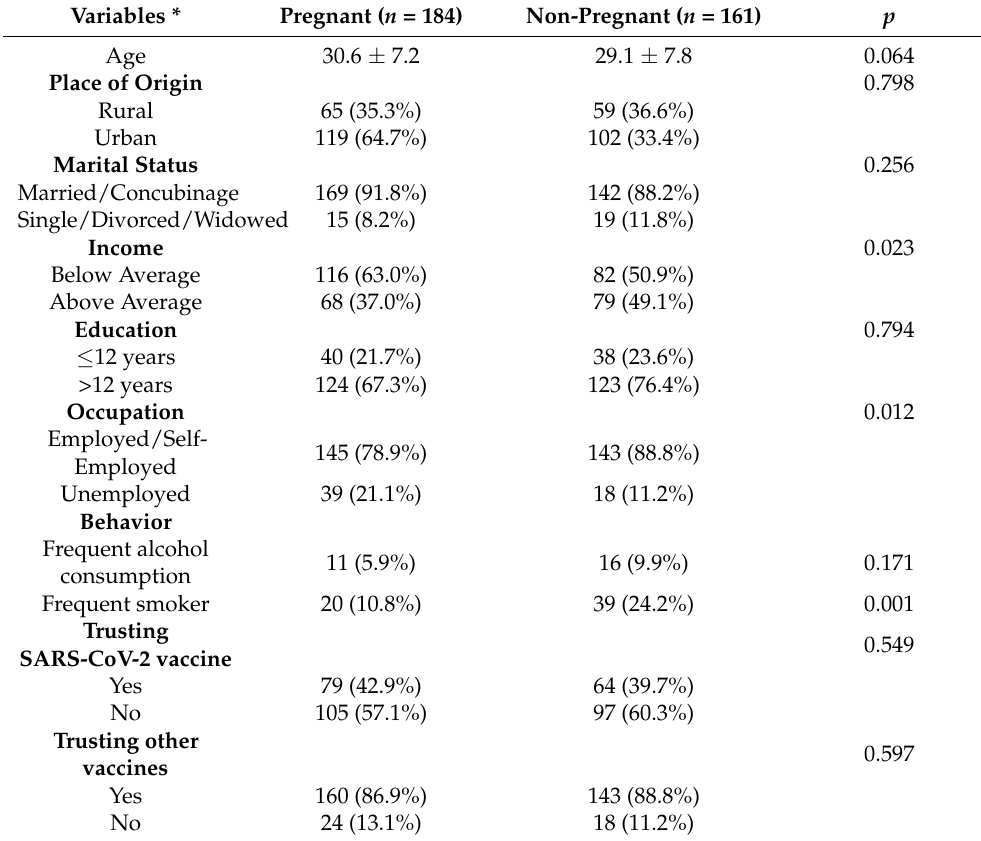
Table 1. Comparison in baseline characteristics between pregnant and non-pregnant study